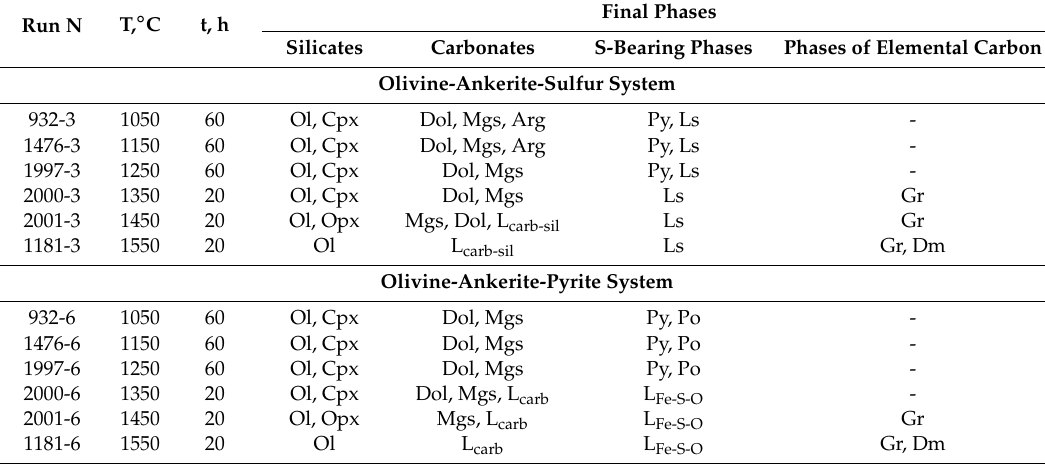
Table 2. Experimental parameters and results in the olivine-ankerite-sulfur and olivine-ankerite-pyrite systems at 6.3